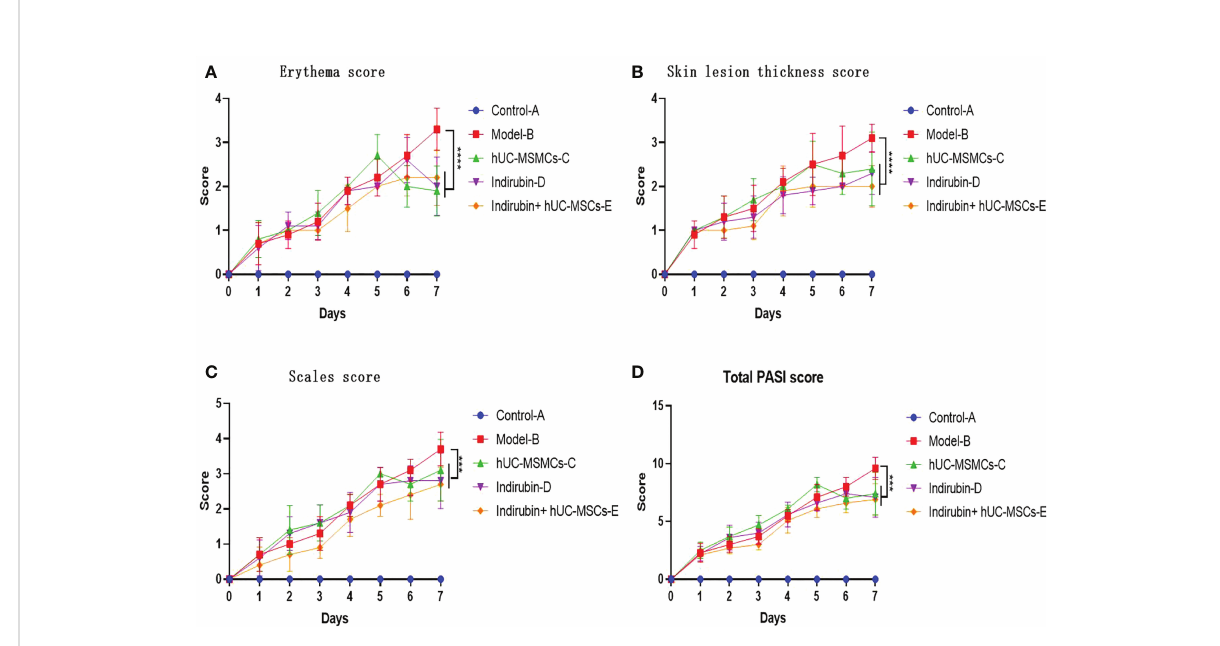
FIGURE 3 The erythema, scale, in fi ltration and PASI score of animals from 0 to 7 days after modeling. (A) Erythema score of mice in each group. (B) Skin lesion thickness score of mice in each group. (C) Scale score of mice in each group. (D) Total PASI score of mice in each group (one-way